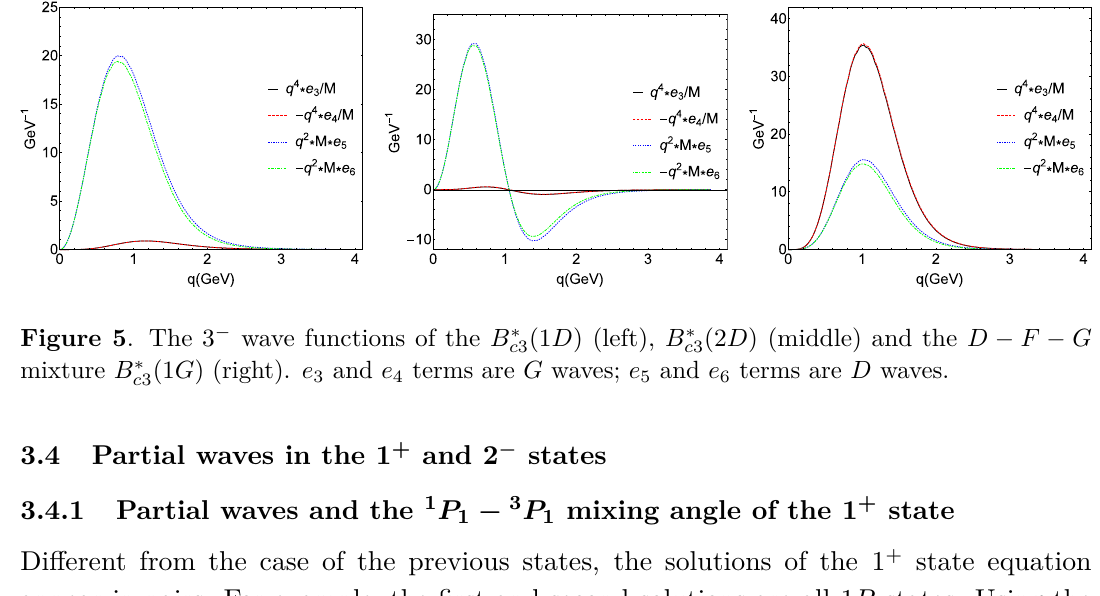
(1 D ) (left), B ∗ (2 D ) (middle) and the D − F − G c 3 c 3